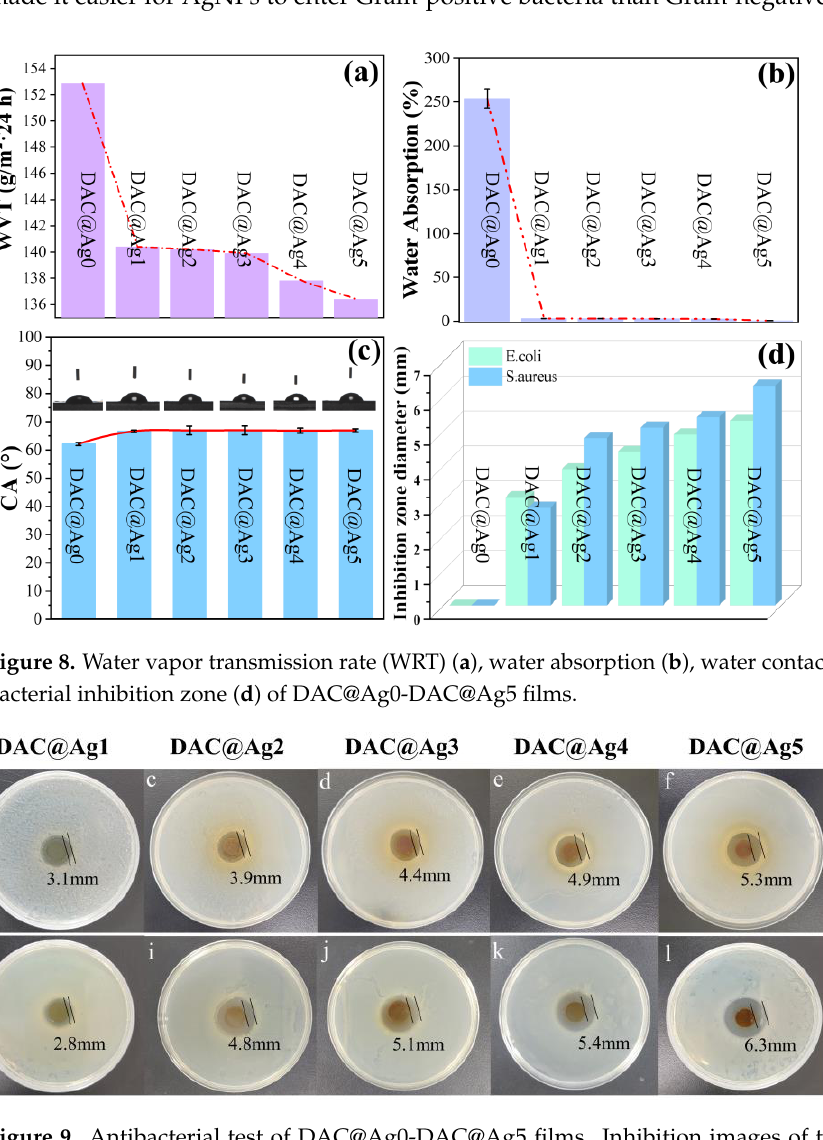
Figure 9. Antibacterial test of DAC@Ag0-DAC@Ag5 films. Inhibition images of the DAC@Ag0- DAC@Ag5 films against E. coli ( a – f ) and S. aureus ( g – l ).